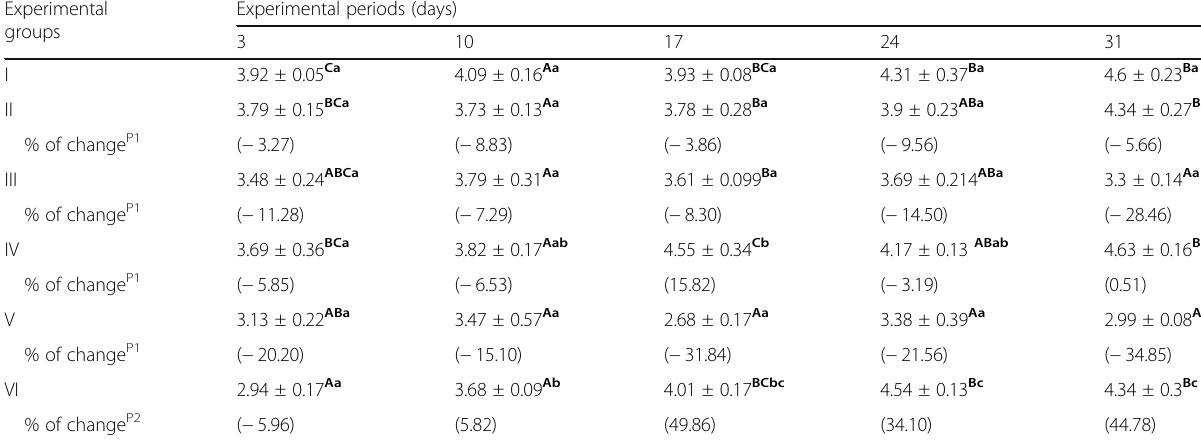
Table 3 Lymphocyte count (10 9 /L) in the experimental groups at the experimental periods Experimental Experimental periods (days) groups